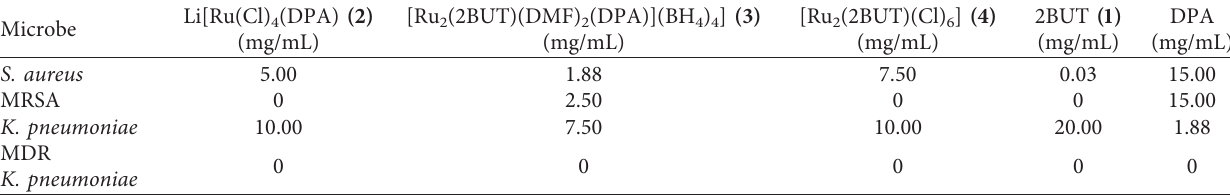
Table 5: MIC of all active compounds.